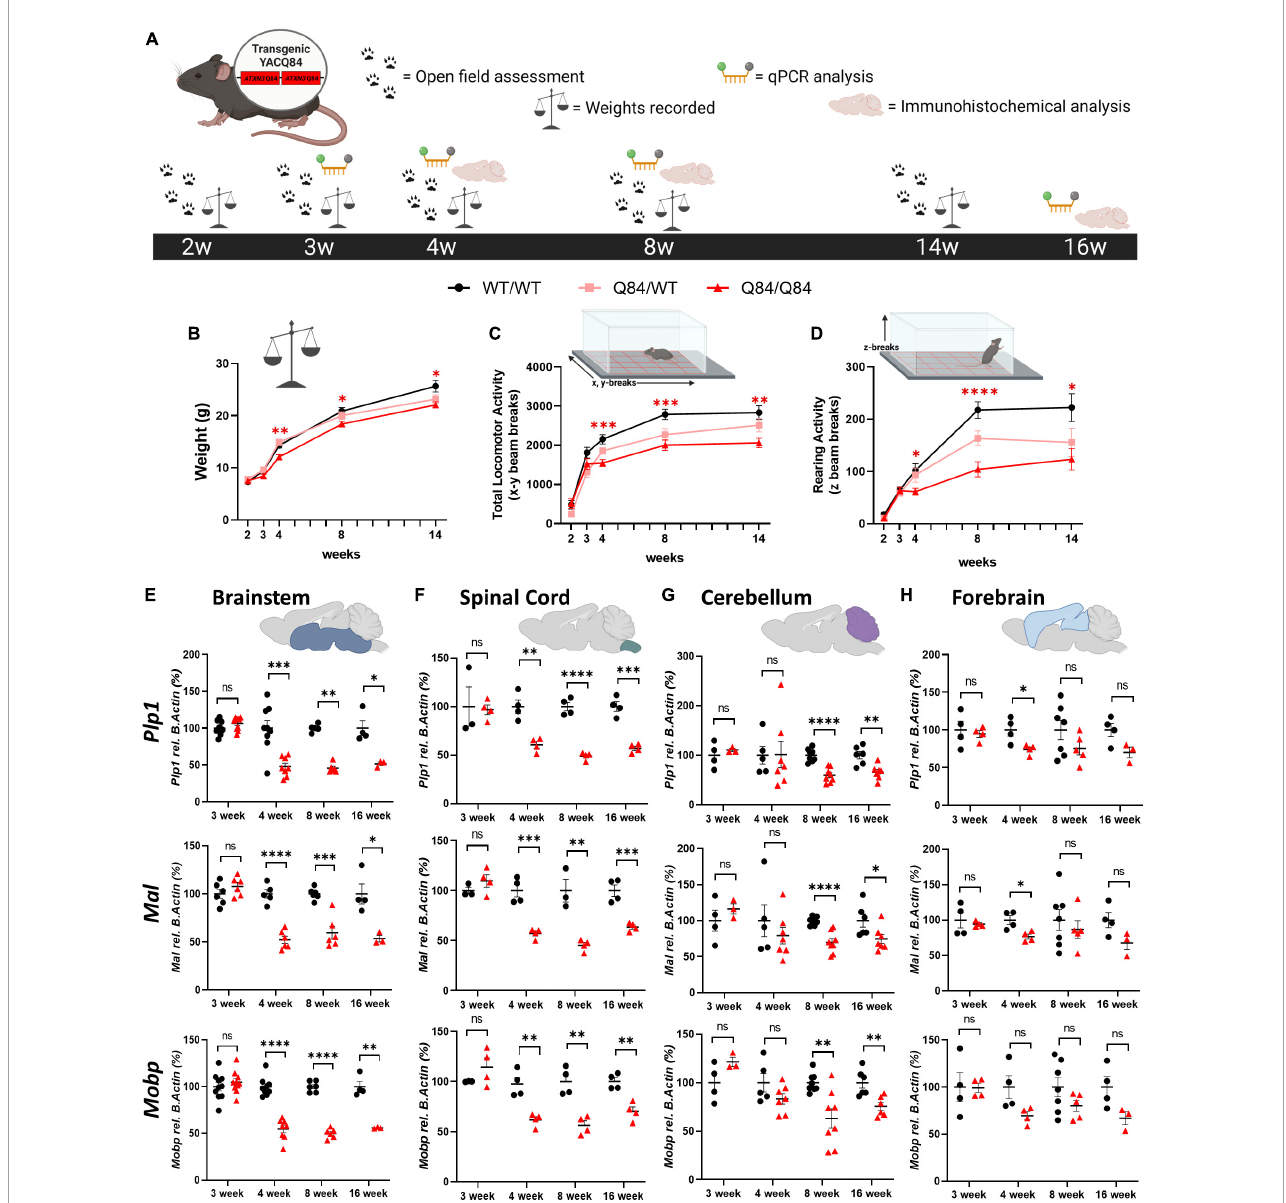
FIGURE3 Onset of behavioral deficits in Q84 mice associates with mature oligodendrocyte transcript dysregulation. (A) Schematic of the recording timepoints for four phenotypic characterizations of Q84 mice. Tissue was collected for qPCR analysis at 3-, 4-, 8-, and 16-weeks-old. Q84; Mobp -eGFP tissue was collected for immunohistochemical analysis at 4-, 8-, and 16-weeks-old. Recordings of panel (B) weight, (C) total locomotor activity (x-y beam breaks), and (D) rearing activity (z beam breaks) in hemizygous (Q84/WT) and homozygous (Q84/Q84) Q84 mice relative to their WT littermates (WT/WT) at 2-, 3-, 4-, 8-, and 14-weeks-old ( n = 16–20 mice/genotype. Mixed-effects analysis with a post-hoc Tukey’s multiple comparison test was performed for behavioral analyses ∗ p < 0.05, ∗∗ p < 0.01, ∗∗∗ p < 0.001, ∗∗∗∗ p < 0.0001; no asterisk, not significant. Red asterisks indicate comparison of Q84/Q84 to WT/WT. (E,F) QPCR analysis of oligodendrocyte maturation markers ( Plp1 , Mal , Mobp ) in Q84 mice in the (E) brainstem, (F) spinal cord, (G) cerebellum, and (H) forebrain. Each data points represents an independent mouse per genotype. For qPCR analysis, unpaired Student’s t -tests or Mann–Whitney tests were performed, depending on normality distribution as determined by Shapiro–Wilk tests: ∗ p < 0.05, ∗∗ p < 0.01, ∗∗∗ p < 0.001, ∗∗∗∗ p < 0.0001; ns, not